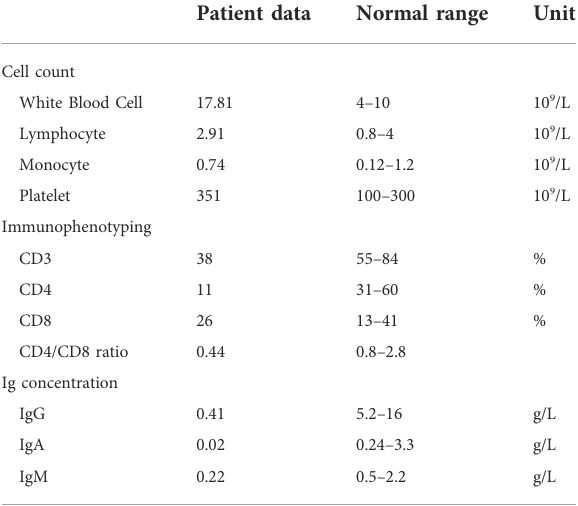
TABLE 1 Abnormal immunological fi ndings of the infant with the associated normal